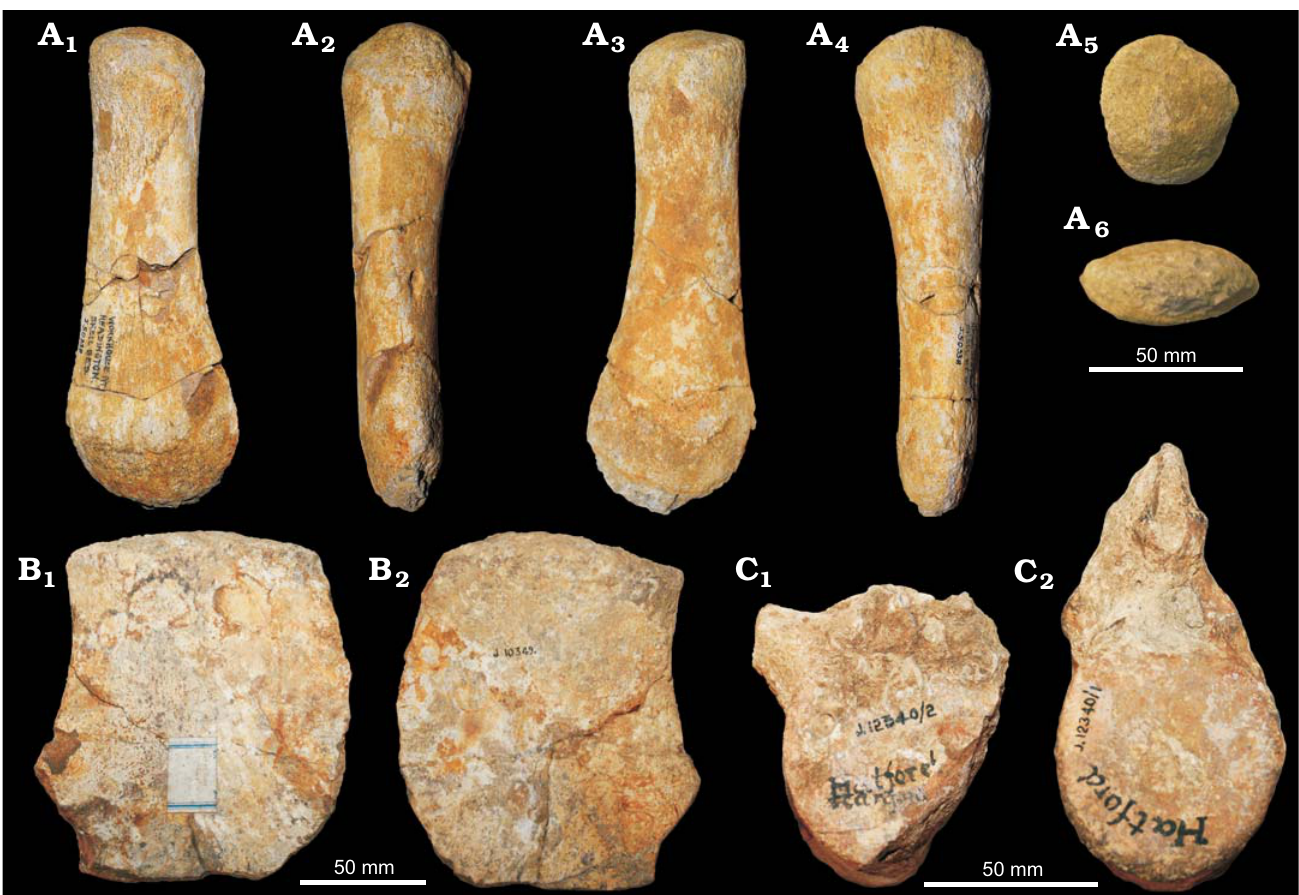
Fig. 6. Postcrania of Plesiosauria indet. A . OUMNH J.50338, ?femur of a juvenile plesiosaur, from Headington (Oxfordshire), ?middle Oxfordian, in lat- eral (A 1 ), anterior (A 2 ), medial (A 3 ), posterior (A 4 ), proximal (A 5 ), and distal (A 6 ) views. B . OUMNH J.10349, from Headington (Oxfordshire), ?middle Oxfordian, fragment of a girdle element in ventral (B 1 ) and dorsal (B 2 ) views. C . OUMNH J.12340/1,2, from Hatford Farington (Berkshire), pectoral (C 1 ) and dorsal (C 2 )